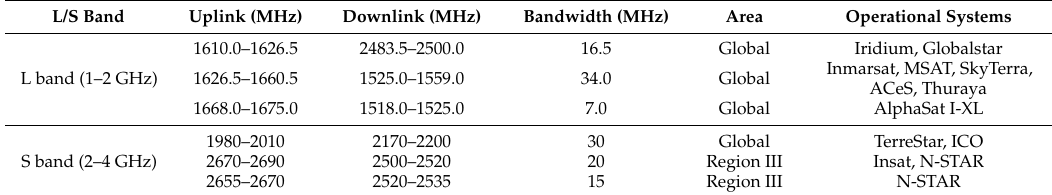
Table 1. L/S band allocation for MSSs by